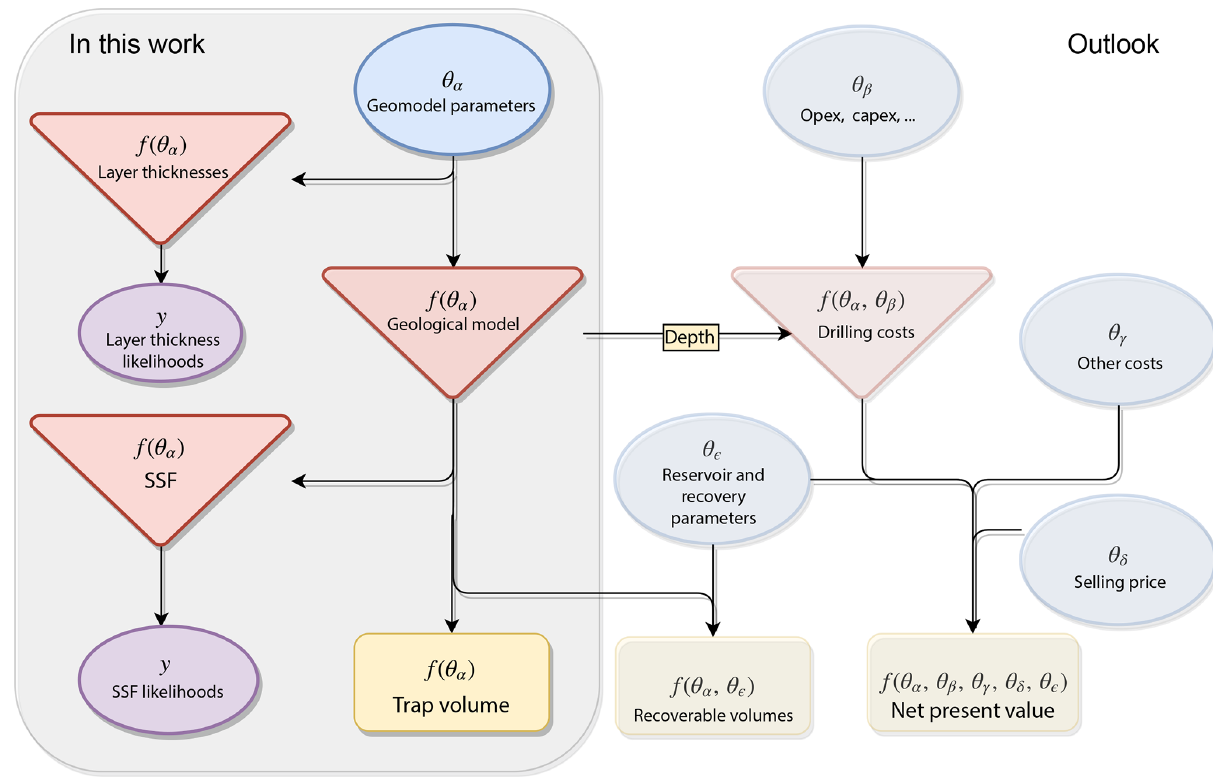
Figure 8. In this work, we applied our loss function approach to estimate a hydrocarbon trap volume. For this, we considered stochastic geomodeling parameters, defined deterministic functions to acquire volume, layer thicknesses, and SSF values, and linked the latter two to respective likelihoods. Regarding the bigger picture, this methodology is expandable and could include other parameters and dependencies. By taking into account other reservoir parameters and recovery factors, we could, for example, base decision-making on recoverable volumes. We could also take depth information from our model and combine this with other cost parameters to calculate drilling costs. Including additional costs, but also the selling price of hydrocarbons, we could attain the NPV as our final value of